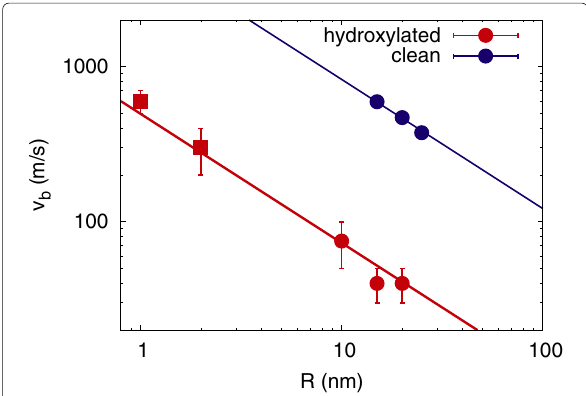
Fig. 3 Bouncing velocity. Dependence of the bouncing velocity, v b , of hydroxylated silica NPs on the NP radius, R . Present (circle) and previous (square) [19] simulation data of hydroxylated silica spheres compared to simulation data of clean silica spheres [15]. Symbols, simulation results. Line: Eq. 2. The error bars of the clean NPs are smaller than the symbol